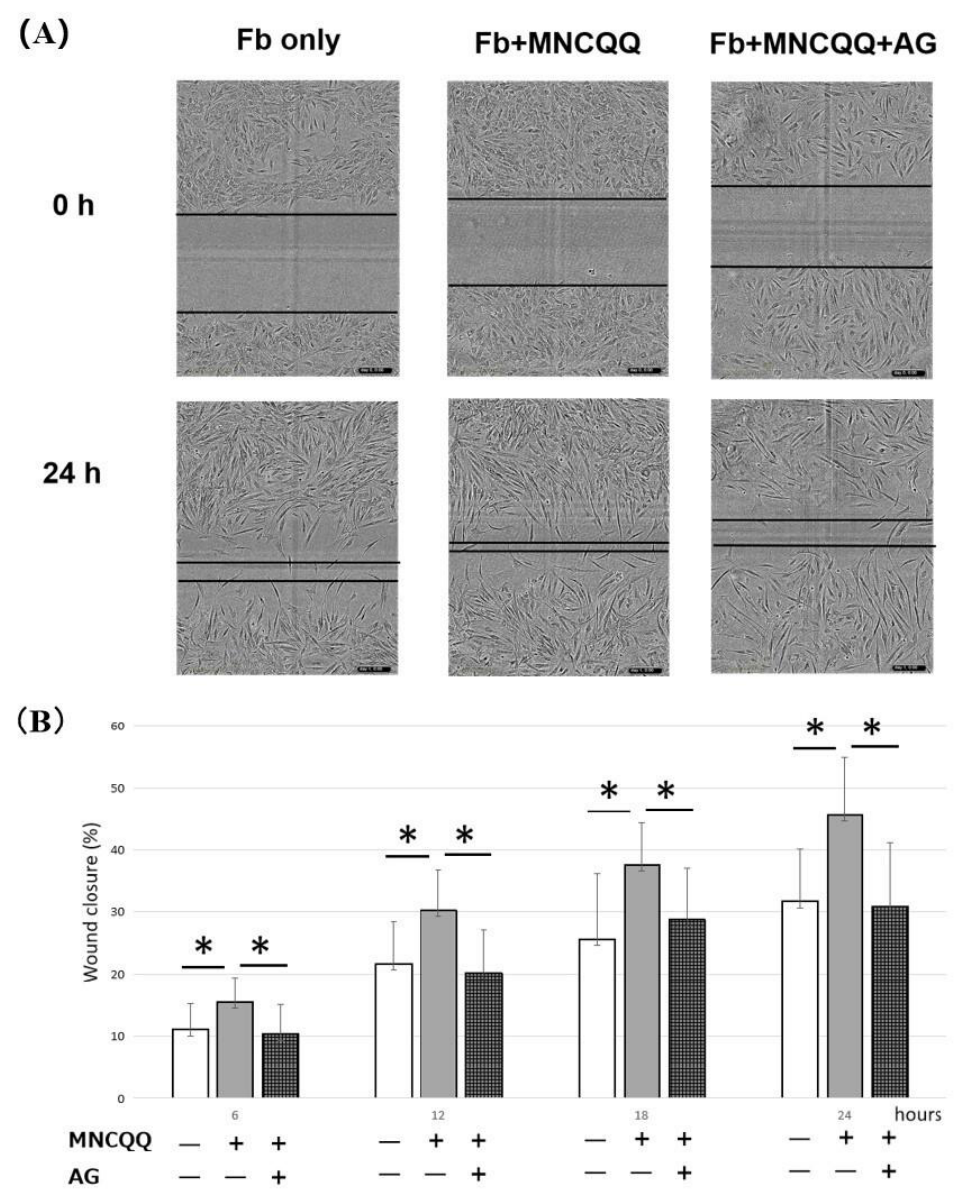
Figure 4. Effect of MNCQQ cells on fibroblasts migration under HG conditions. ( A ) Migration ability was measured by the wound − healing assay, and ( B ) the relative wound recovery was presented as % recovery of the wound distance at 6, 12, 18, and 24 h relative to 0 h (magnification, × 100). N = 4 volunteers. *; vs. Fb + MNCQQ, p < 0.05; Fb only: fibroblasts only in high glucose; Fb + MNCQQ: fibroblasts cocultured with MNCQQ cells in high glucose; Fb + MNCQQ + AG: fibroblasts cocultured with MNCQQ cells in high glucose with AG applied.